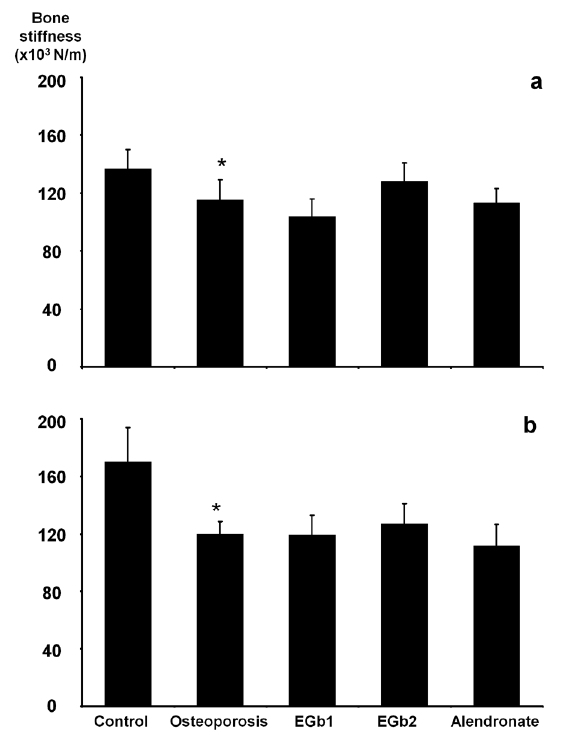
Figure 4 - Mechanical properties of the three-point bending test-bone stiffness. a - 20 days of treatment. b - 30 days of treatment. *p<0.05 when the control group was compared to the osteoporosis group (Student`s